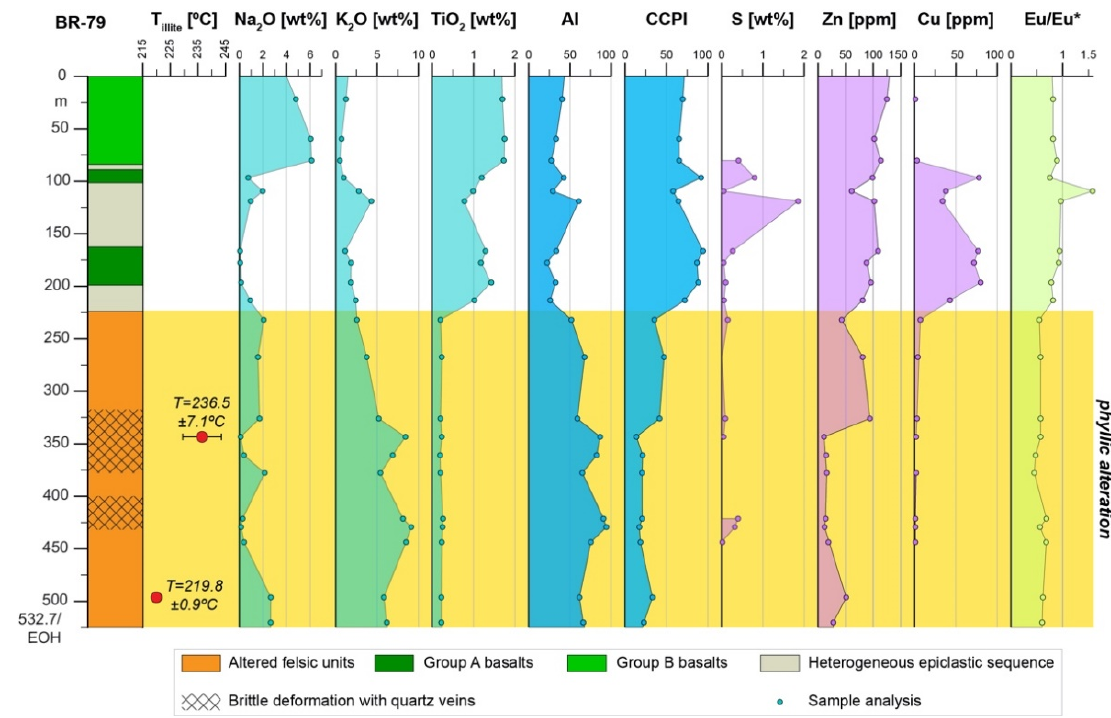
Figure 26. Vertical changes in major and minor element composition (Na 2 O, K 2 O, TiO 2 ), alteration intensity (AI, CCPI), S and base metal content (Cu, Zn), and Eu anomaly (Eu/Eu*) in lithologies at the A6 Anomaly based on drillhole BR-79, Note that phyllic alteration (yellow area) in altered felsic units is strongest at higher T that correlate with brittle deformation, T illite is based on calculations using illite composition (Equation (6); [70]).